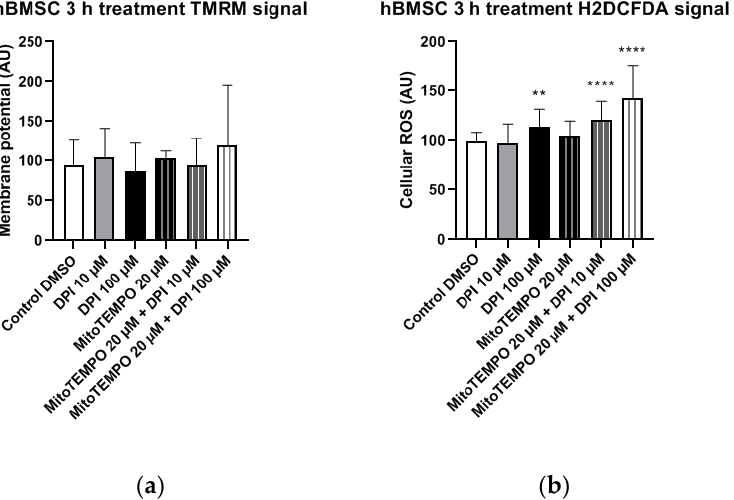
Figure 9. Mitochondrial membrane potential and cellular ROS levels 3 h after treatment of hBMSCs with diphenyleneiodonium chloride (DPI) and MitoTEMPO. ( a ) Changes in the mitochondrial membrane potential. ( b ) Changes of cellular ROS levels; the increase is caused by the mitochondrial effects of DPI. Data is represented as means + SD (error bars) ( n = 36; each point was obtained by analyzing 2–4 single cells. ** p < 0.01, and **** p < 0.0001; one-way ANOVA followed by multiple comparison post-hoc Fisher’s LSD